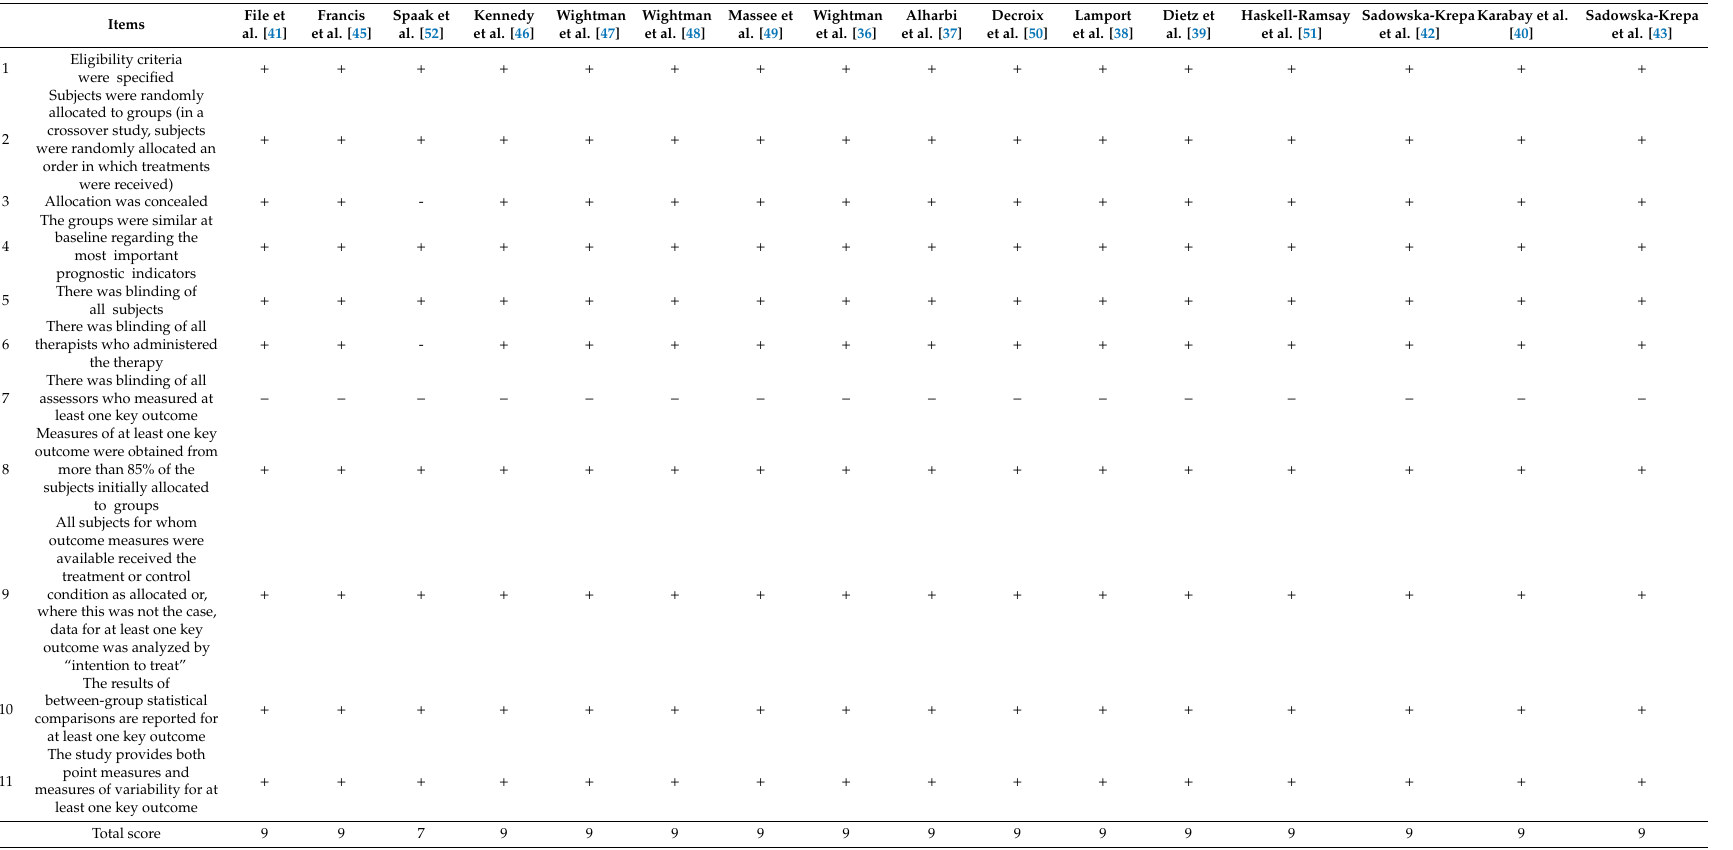
Table 3. Methodological quality of the studies with (poly)phenol-rich supplementation assessed with the PEDro